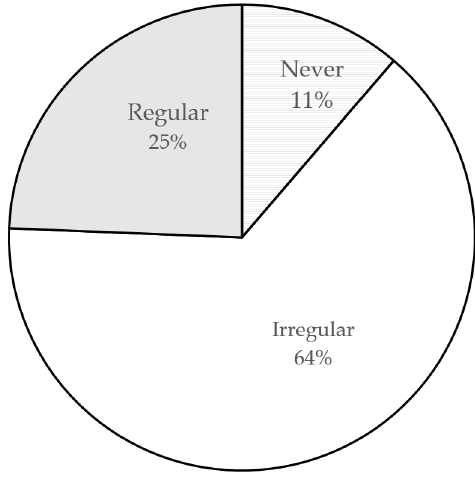
Figure 6. How often consumers clear up their drug cabinets.